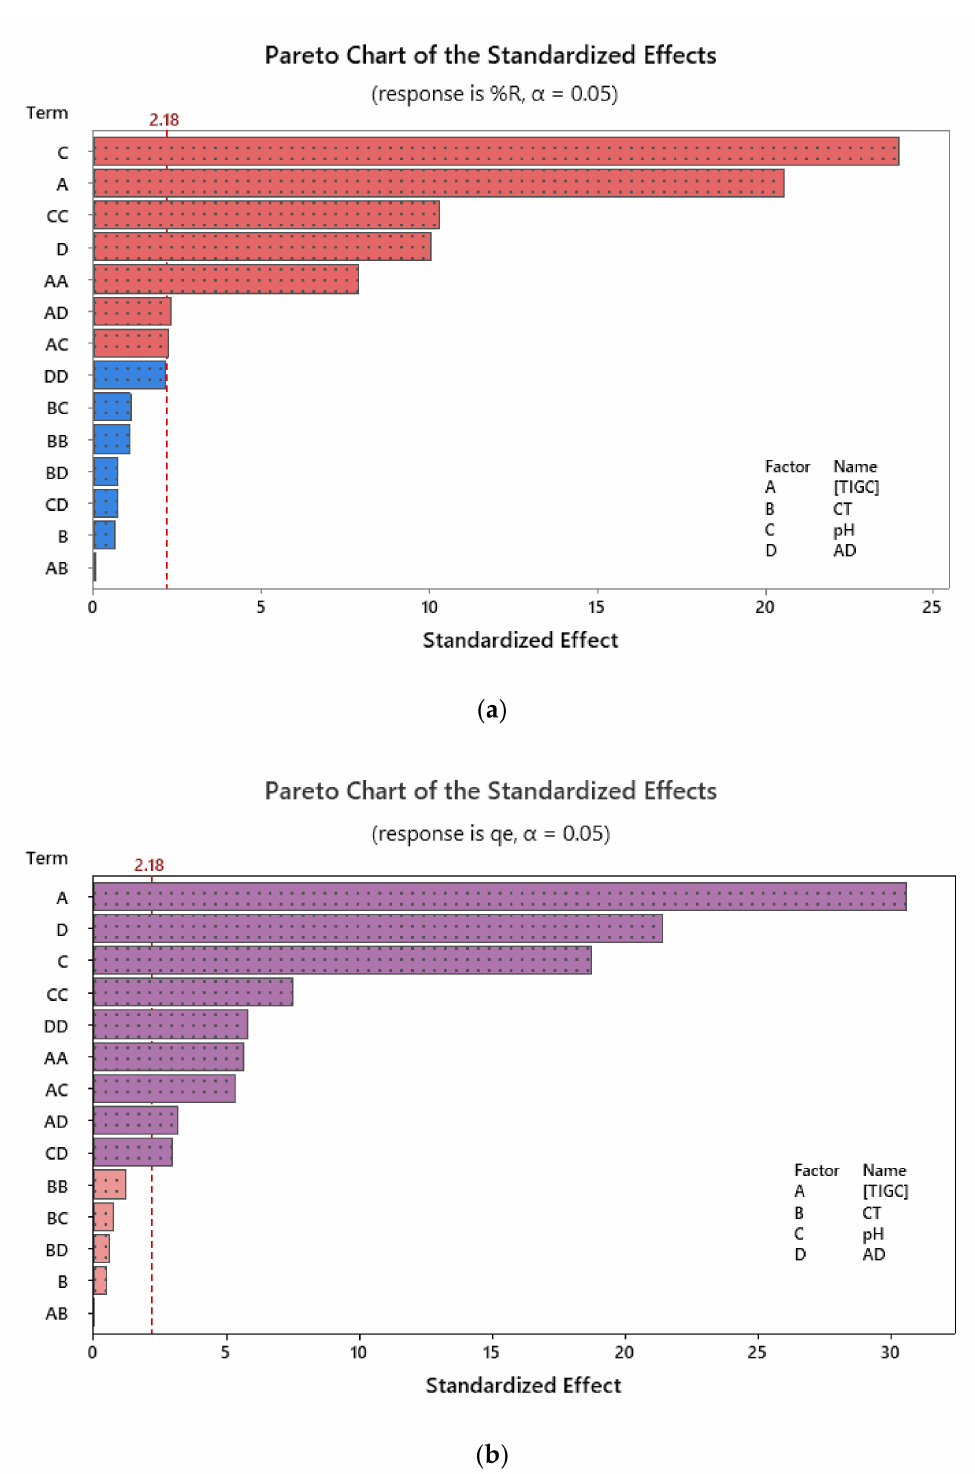
Figure 7. Pareto chart of standardized effects using MBC-DP as adsorbent where ( a ) %R; ( b ) q e (mg/g) are the measured responses, respectively. Data were obtained following response